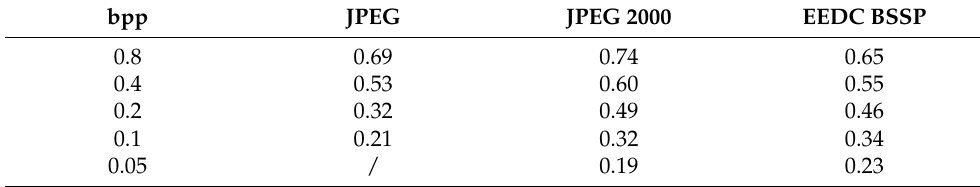
Table 17. Results of the VIF metric for image mask .